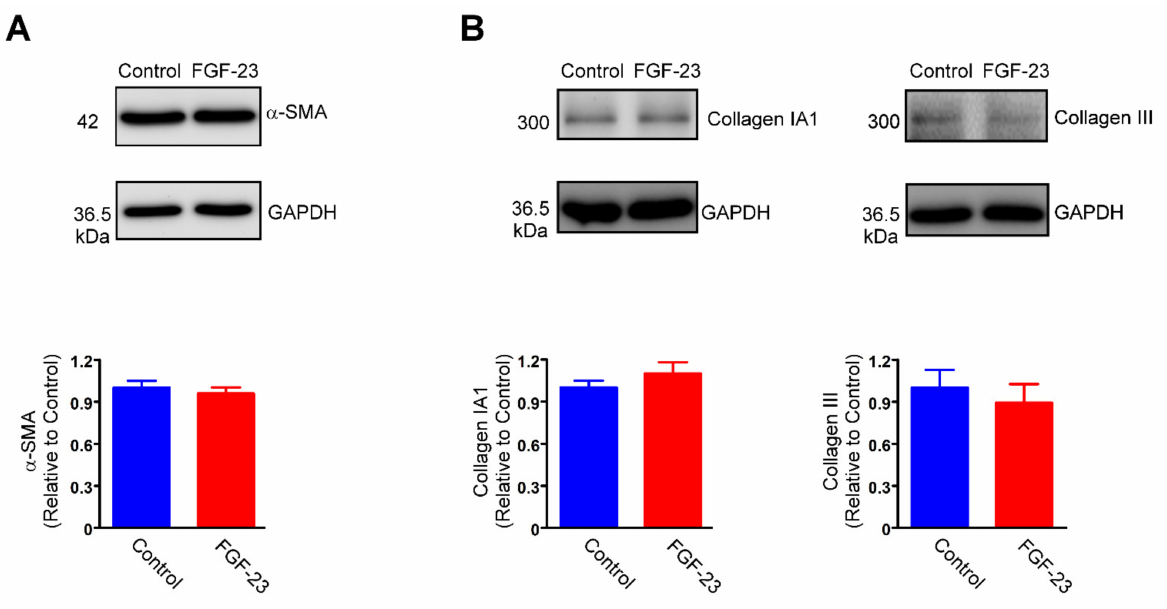
Figure 2. The α -smooth muscle actin ( α -SMA) expression and collagen production in control and fibroblast growth factor (FGF)-23-treated human atrial fibroblasts. Representative immunoblots and average data of α -SMA ( A ), collagen type IA1 and collagen type III ( B ) from control and FGF-23 (25 ng/mL)-treated cardiac fibroblasts ( n =